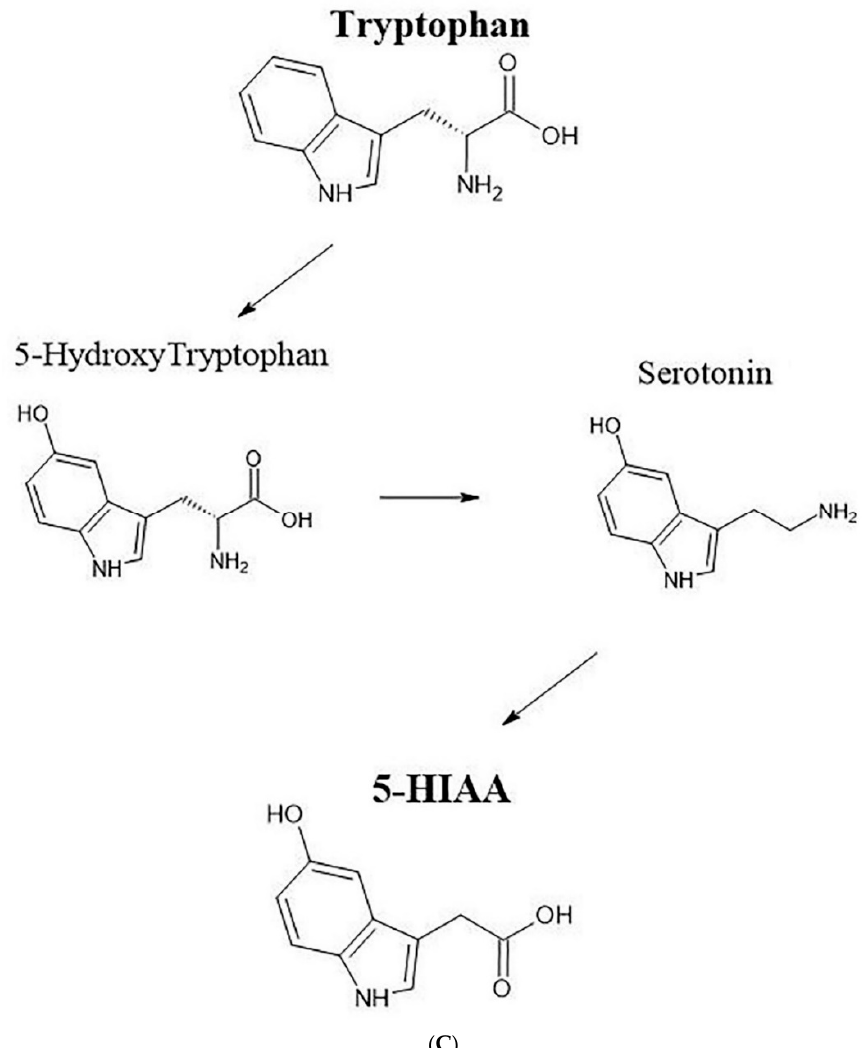
Figure 6. Metabolic pathway diagram summarizing the metabolites altered in response to 5F- APINAC administration: ( A ) the kynurenine metabolic pathway, ( B ) serotonergic system/serotonin pathway, aspartic acid innervation system and ( C ) microbial tryptophan catabolism pathway.